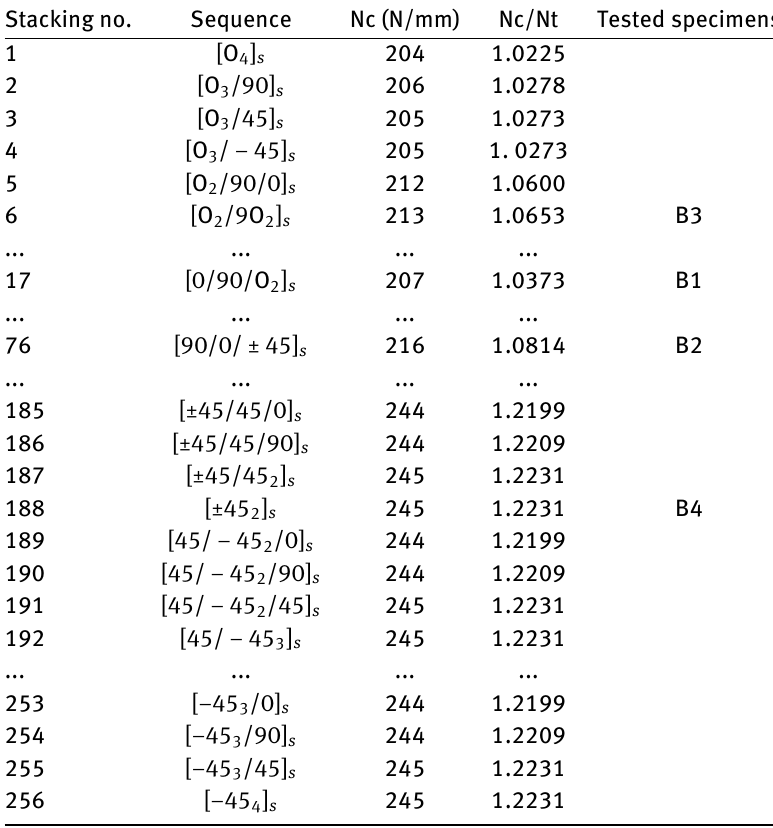
Table 4: Analytical critical buckling load for all possible stacking sequences of 8 layers of symmetric UD laminates when the set target buck- ling load is 200N/mm. All passed.